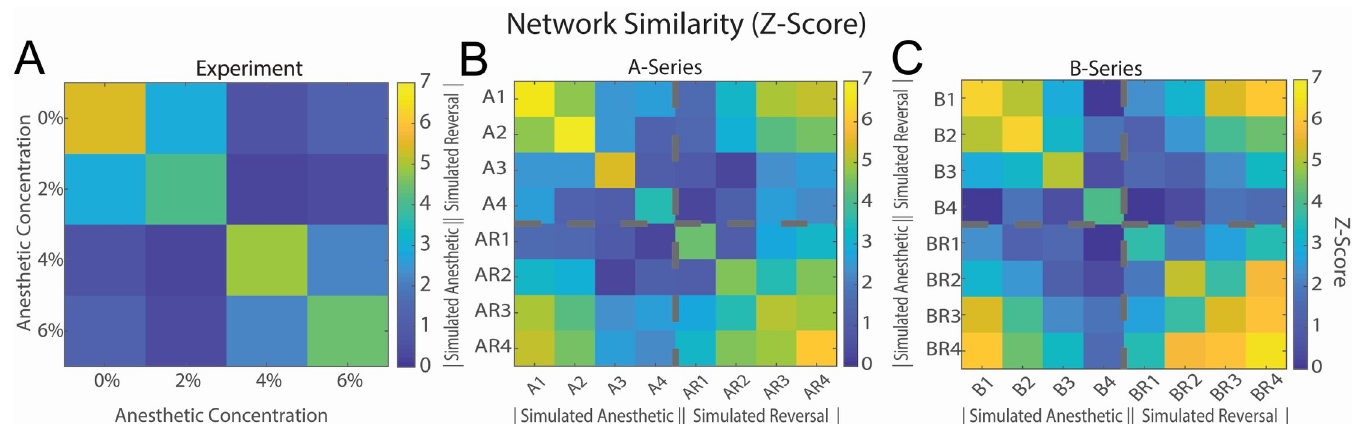
Fig 7. Effects of anesthetic concentration and ACh induced reversal on similarity between cellular functional connectivity. Cosine similarity Z-Score was computed for every pairwise functional connection between neurons. A) Experimental functional connectivity was computed between the highest firing neuron for each electrode with similarity computed across different levels of anesthesia. B,C) Functional network similarity computed for simulated anesthesia and reversal. Z-Scores were computed comparing the Network similarity to mean and standard deviation of similarities for distributions randomly jittered +/- 5 milliseconds. Each is averaged over ten